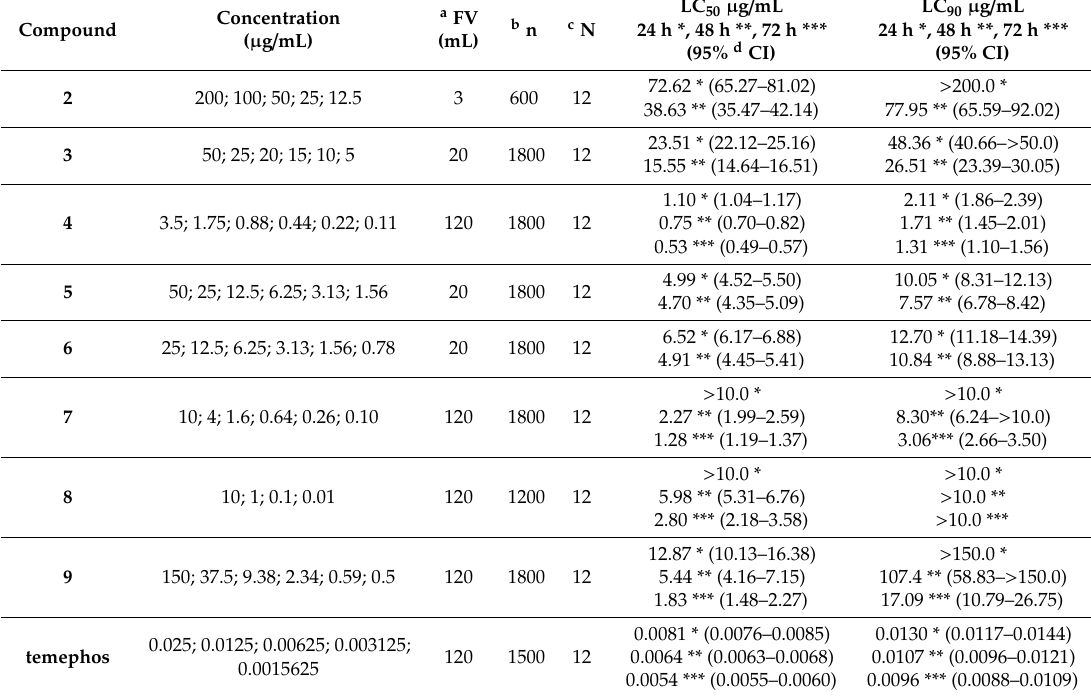
Table 1. LC 50 ( µ g / mL) and LC 90 ( µ g / mL) data for compounds 2 – 9